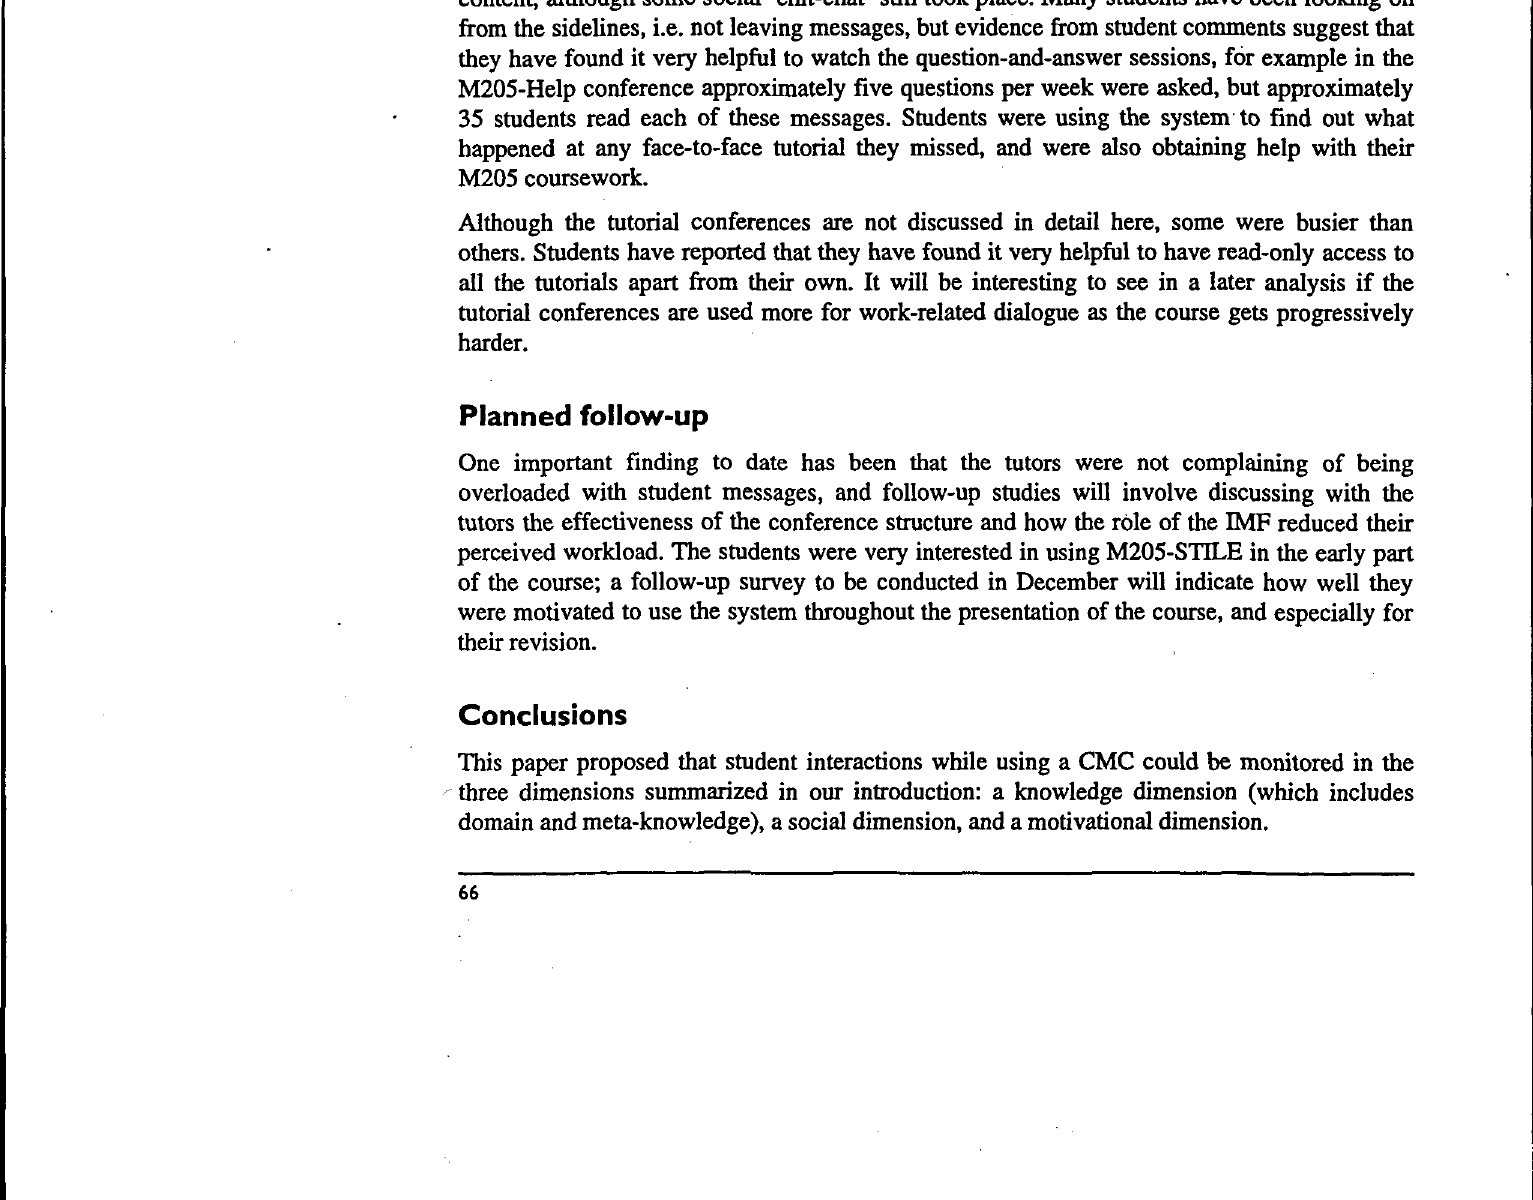
Figure 6: Students' interest in using the system at the beginning of the project Summary of